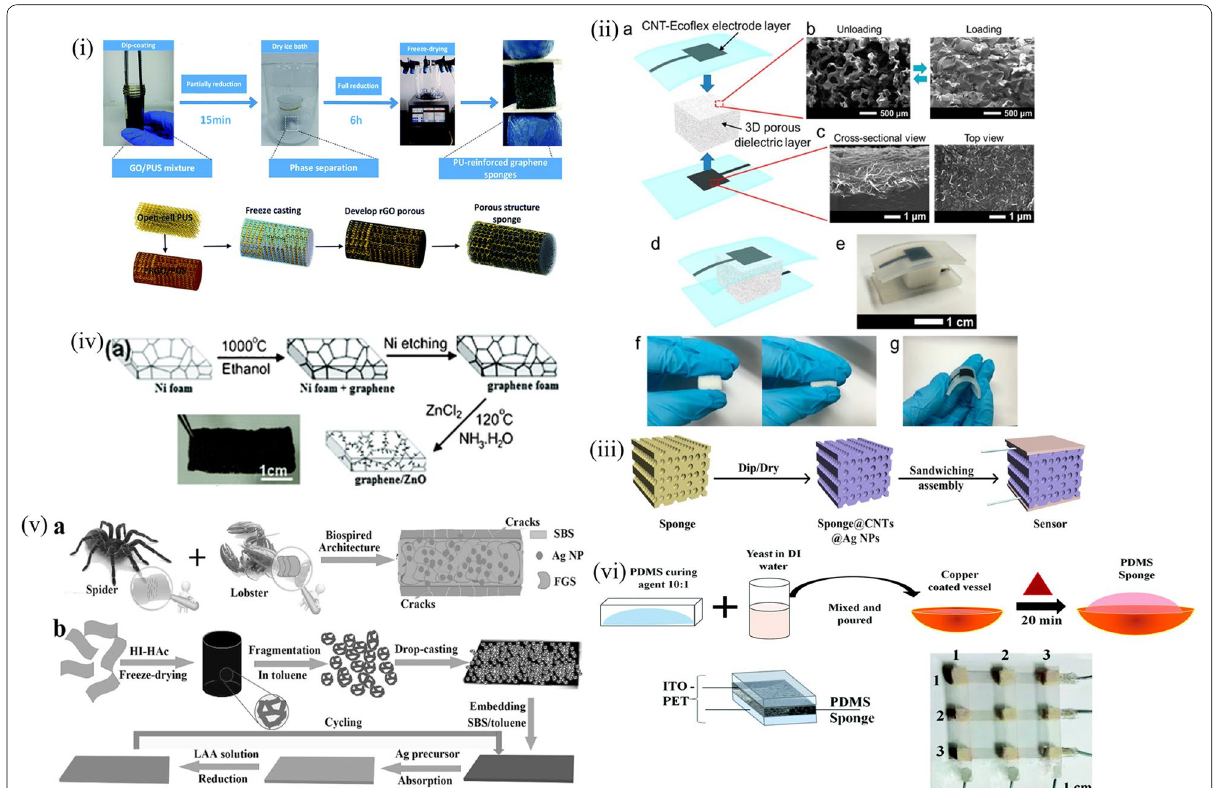
Fig. 6 Porous elastomer based sensor (i) PU sponge based porous grapheme structure (Reproduced by permission from [91] Copyright 2017, Royal Society of Chemistry ) (ii) Elastomer sponge made from sugar cube template for capacitive sensor (Reproduced by permission from